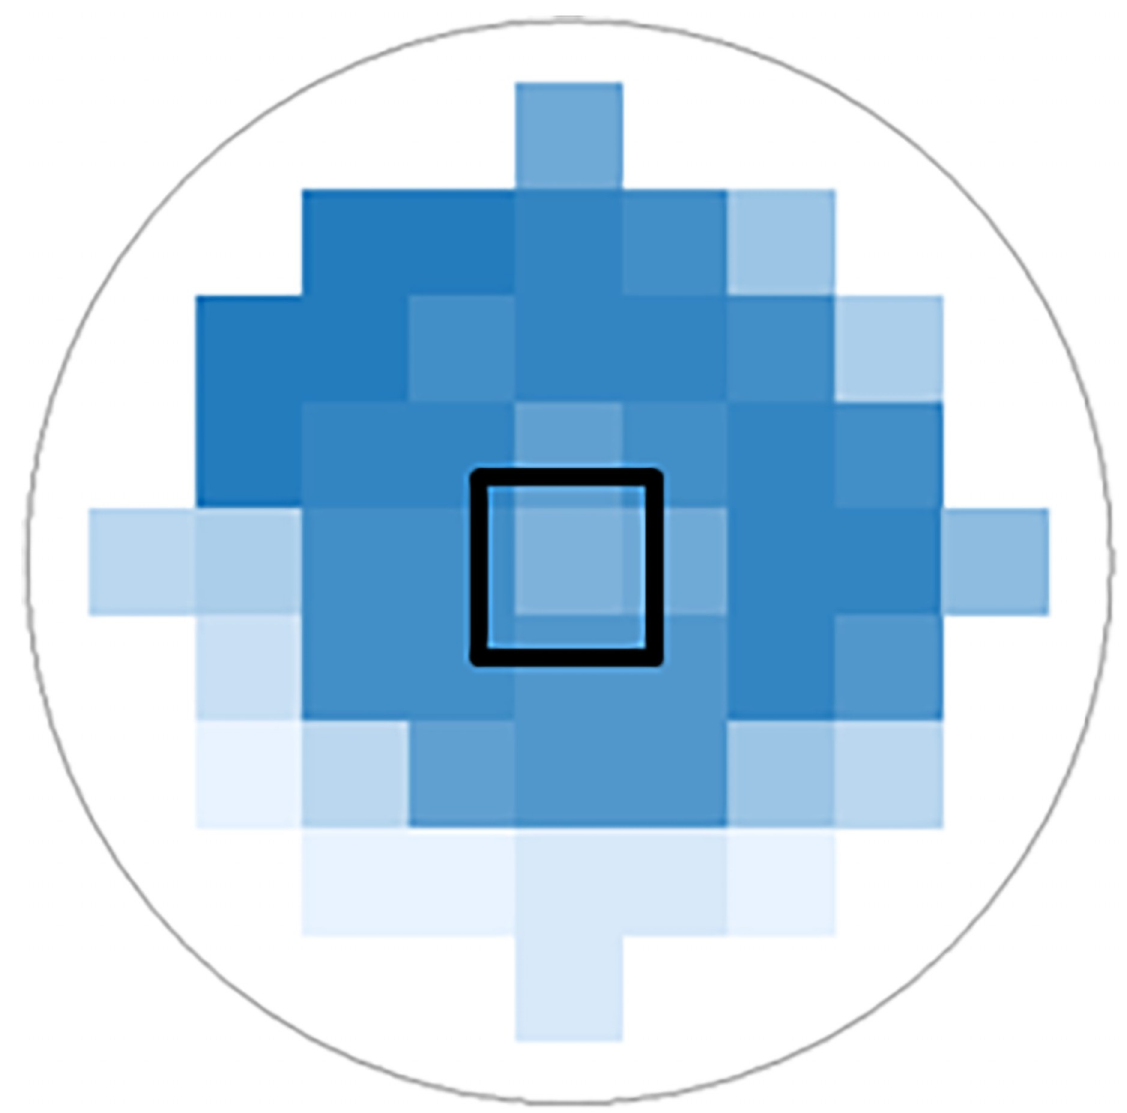
Fig 3. Heat map of absorbance measurements of a tympanic membrane at 300 nm with a 9x9 matrix. The point with the least absorbance (ROI) was marked in black. Spots with no light transmission are presented as white areas in the heat